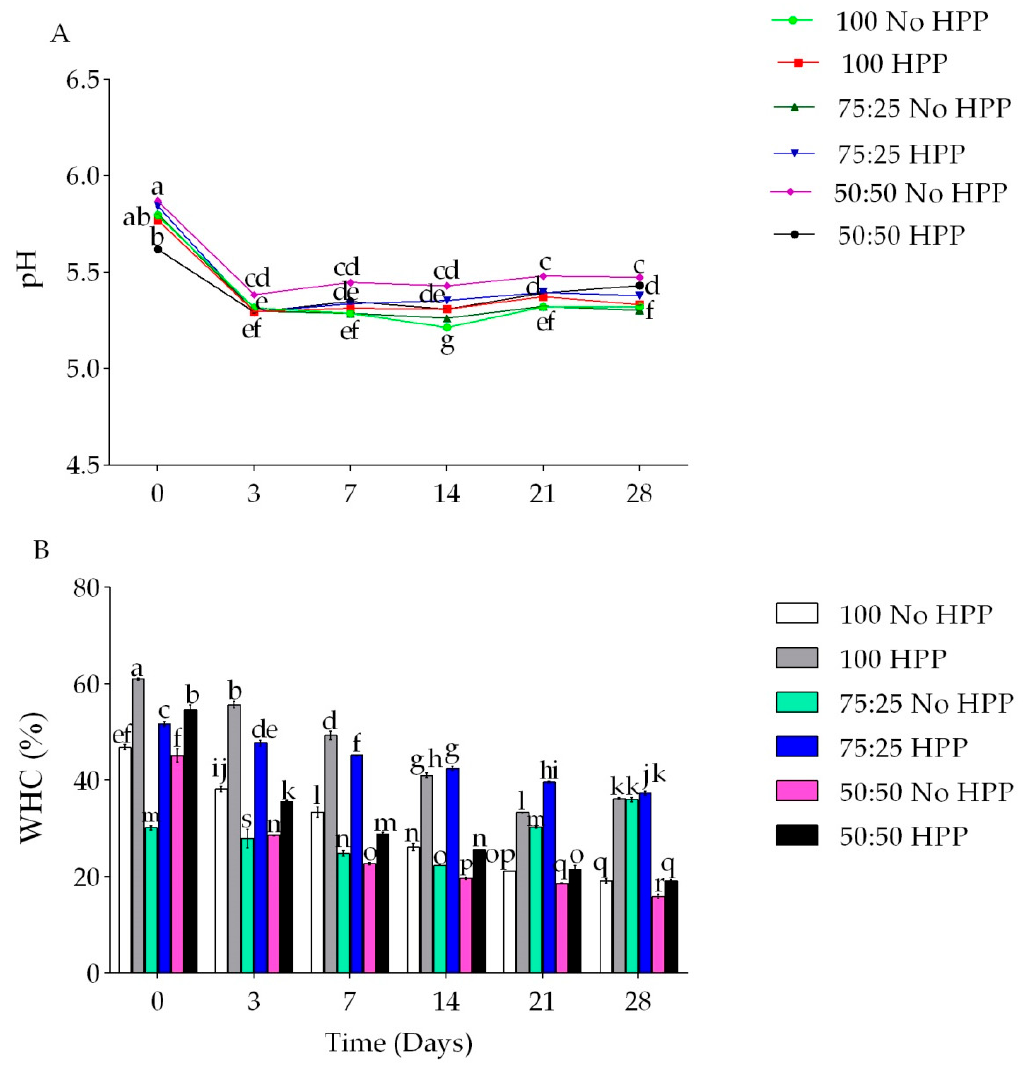
Figure 2. Effect of partial substitution of NaCl coupled with HPP on ( A ) pH and ( B ) water-holding capacity of beef sausage under different cold storage days. Data were presented in means ± SD. Different lower case letters indicate significant differences at p < 0.05 in Duncan’s multiple range tests using two-way ANOVA.